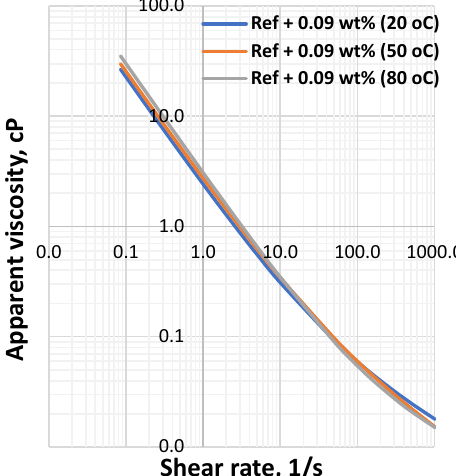
Figure 6. Reference MoS 2 -free drilling fluid.